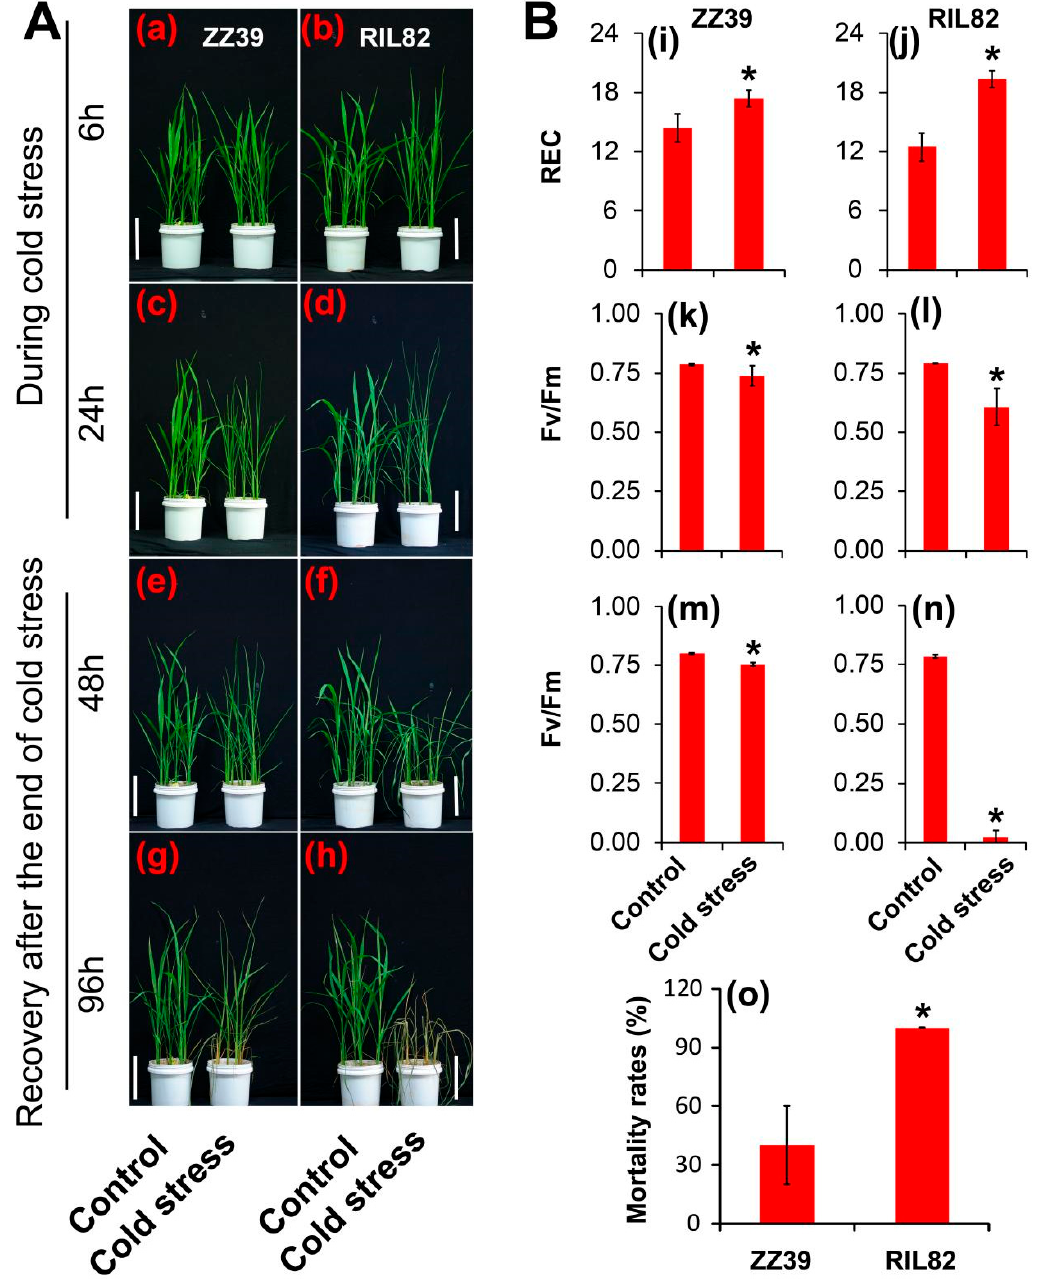
Figure 1. The response of rice plants to cold stress. ( A ), The morphology of rice plants under cold stress. ( a , b ), ZZ39 and RIL82 plants were subjected to cold stress for 6 h, respectively; ( c , d ), ZZ39 and RIL82 plants were subjected to cold stress for 24 h, respectively; ( e , f ), The recovery of ZZ39 and RIL82 plants for 48 h after the end of cold stress, respectively; ( g , h ), The recovery of ZZ39 and RIL82 plants for 96 h after the end of cold stress, respectively. ( B ), Changes in the REC, Fv/Fm and mortality rate of ZZ39 and RIL82 plants under cold stress. ( i – l ), The REC and Fv/Fm of ZZ39 and RIL82 plants under cold stress for 24 h; ( m , n ), Fv/Fm of ZZ39 and RIL82 plants recovered for 48 h after the end of cold stress; ( o ), Mortality rates of ZZ39 and RIL82 plants recovered for 96 h after the end of cold stress. REC, relative electrical conductance; Fv/Fm, maximum fluorescence quantum efficiency. The reference scales of ( a – h ), all represent 10 cm. Vertical bars denote standard deviations ( n = 5). A t -test was adopted to compare the differences between the control and cold stressed within a cultivar. * denotes p < 0.05.